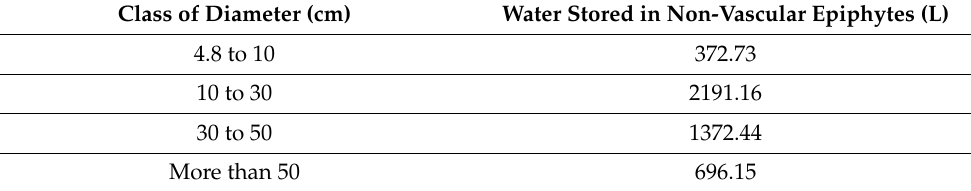
Table 2. Water stored in non-vascular epiphytes (L) for each diameter class (cm).